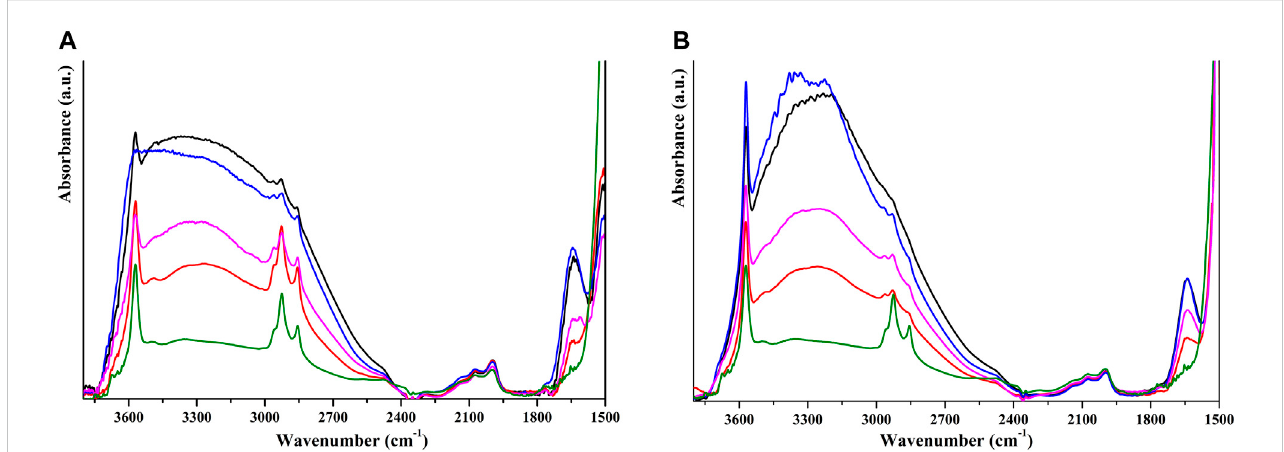
FT-IR spectra of self-supported pellets of HP NPs coated with FAs (A) and HAs (B) after outgassing (black lines), thermal activation at 120 ° C (red lines), addition of water vapor (blue lines) and outgassing (pink lines). Spectra of starting HP NPs after thermal activation at 120 ° C are reported as green line.